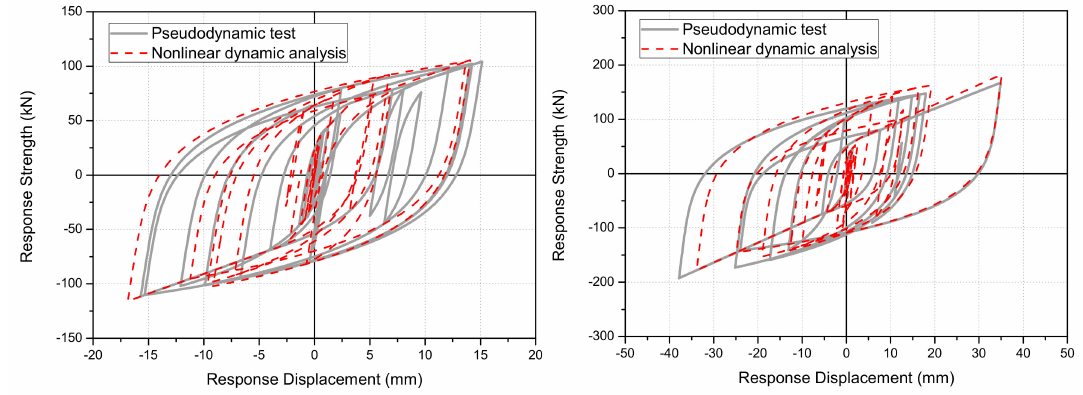
Figure 26. Comparison of seismic response load-displacement and displacement hysteresis loops during nonlinear dynamic analysis and pseudo-dynamic tests of the test frame retrofitted with NBSD-WSCS (first floor, 300 cm/s 2 ).